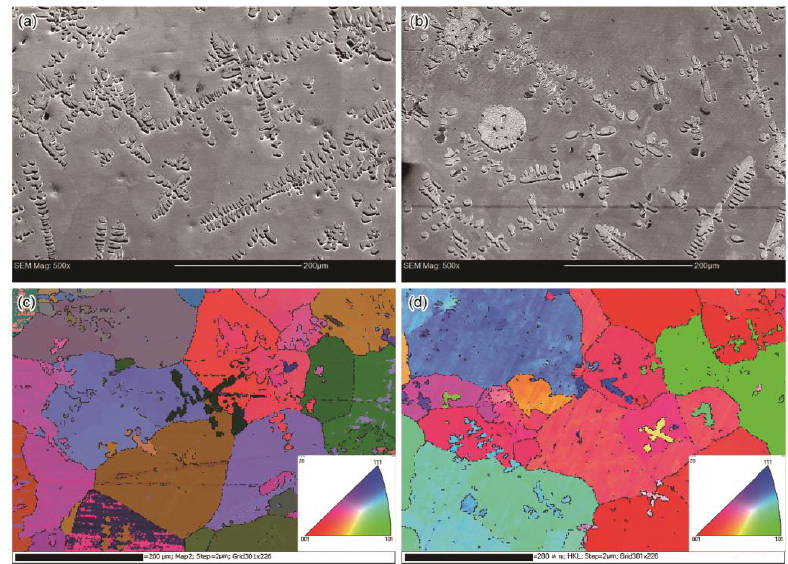
Figure 6. Electron Backscattered Diffraction (EBSD) orientation image of the Cu-15%Co alloys and the corresponding field emission scanning electron microscopy (FESEM) micrographs: ( a ) FESEM image of specimen without EMS; ( b ) FESEM image of specimen stirred with current 16 Hz/200 A; ( c , d ) corresponding crystallographic maps to ( a , b ), with colors representing different crystal planes.